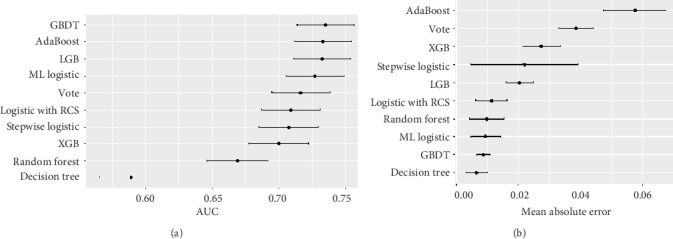
Results of discrimination and calibration metrics of machine learning and logistic regressions in the validation cohort. The AUC (a) and mean absolute error (b) are presented in each model as mean and 95% confidence intervals.